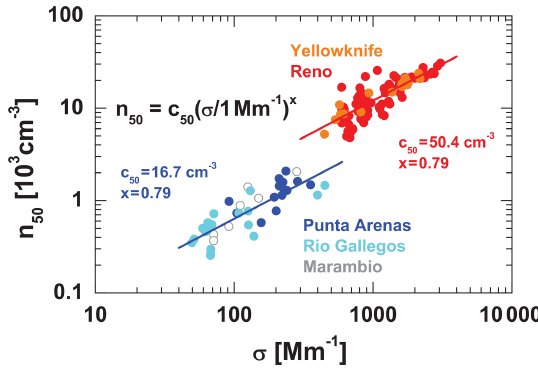
Figure 10. Relationship between smoke extinction coefficient σ (532nm) and particle number concentration n 50 for the combined Reno and Yellowknife data set (fresh and aged smoke) and the com- bined South American and Antarctic data set (aged